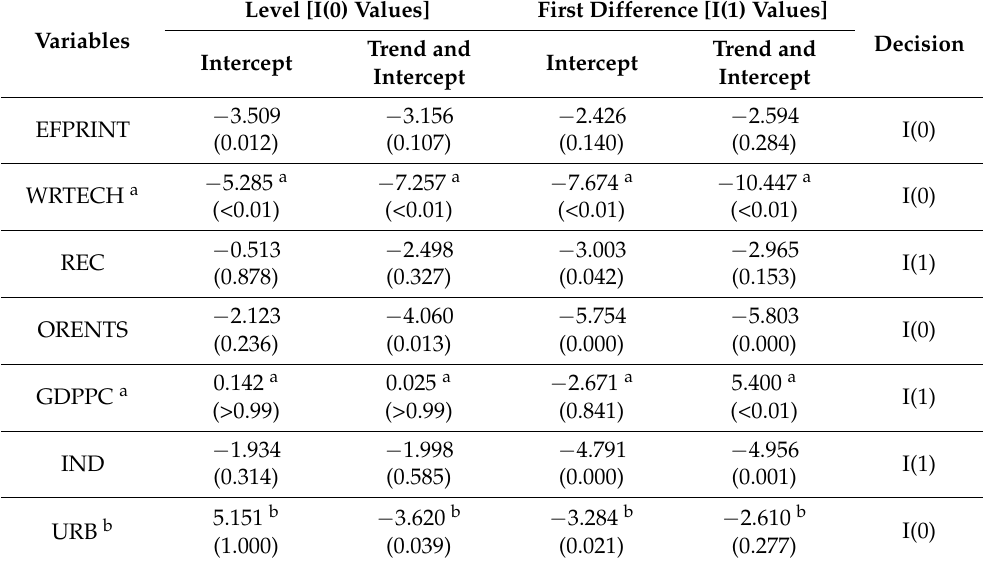
Table 5. ADF unit root test estimates.